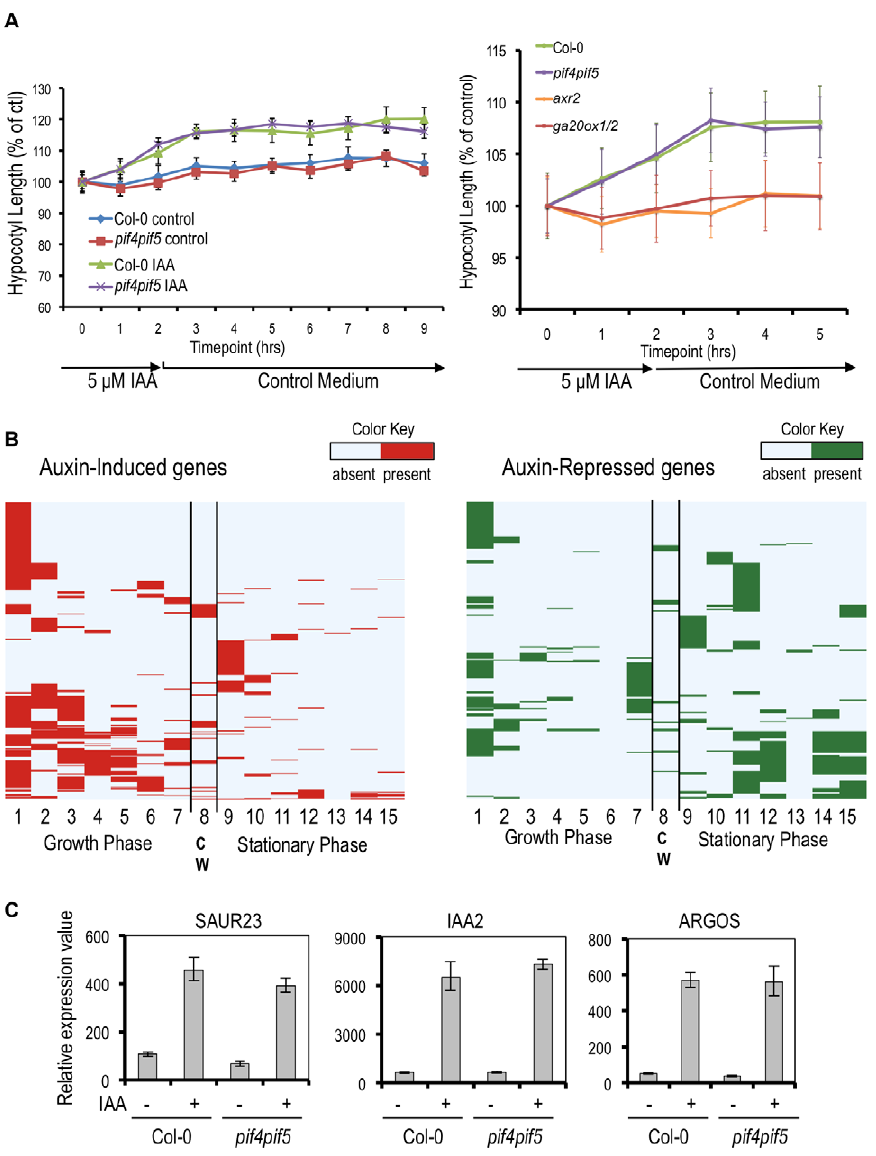
Figure 6. Auxin promotes hypocotyl elongation through PIF-dependent and –independent pathways. PIF4 and PIF5 are not required for transient auxin response. Average hypocotyl length of wild-type (Col-0) or pif4pif5 mutant seedlings treated with 5 m M IAA for two hours was measured each hour for 7 hours. Error bars indicate standard error. Hypocotyl length at each time point is shown as a percentage of length at time 0. (B) Auxin-responsive genes are associated with growth conditions. Picloram-induced genes are also induced in the dark (column 1, up in WTD) and during growth (2, upG; 6, upG PIF4/5), and repressed by light (3, down in WTRc; 7, DL) and in the pifq mutant (4, down in pifqR1; 5, down in pifqD). Picloram-repressed genes are also repressed in the d ark (colu mn 9, down in WTD) and upregulated by light (10, upL; 15 up in WTRc), during stationary phase (11, upS; 13 Nozue upS PIF4/5), and in the pifq mutant (12, up in pifqR1; 14, up in pifqD) (see Methods, Table 1 and Table S6 for complete description of array conditions shown). CW indicates genes associated with cell wall metabolism (column 8). (C) PIF4/5-dependent genes are regulated by auxin in seedlings. Wild-type (Col-0) or pif4pif5 mutant 5-day-old seedlin gs were t reated with 5 m M IAA or a solvent control for 2 hours and used for RNA isolation. Expression value of each gene shown, relative to a control gene, was determined by